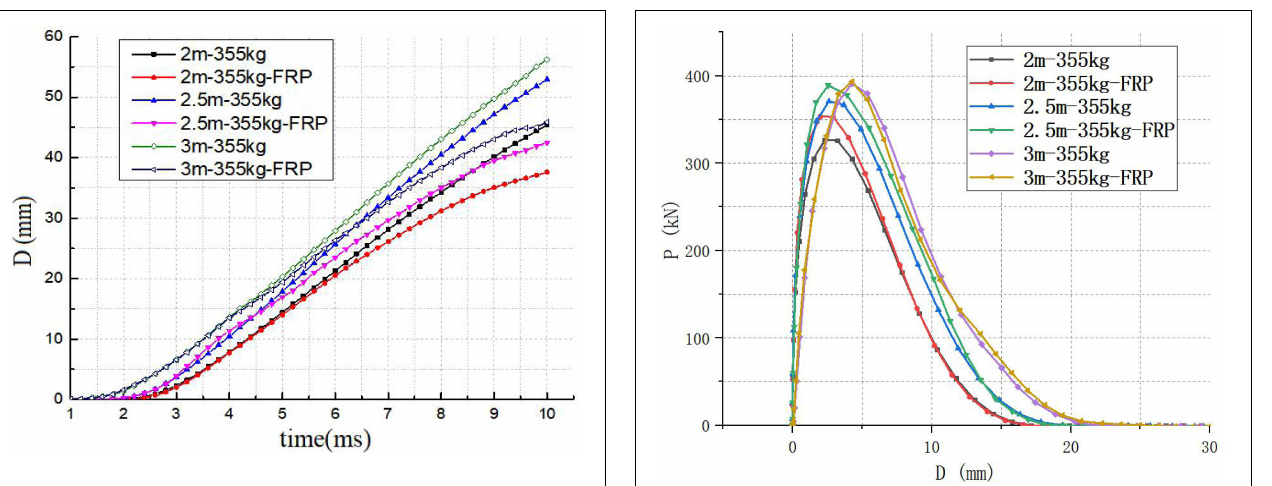
FIGURE 14 | Displacement time history curves at different heights.